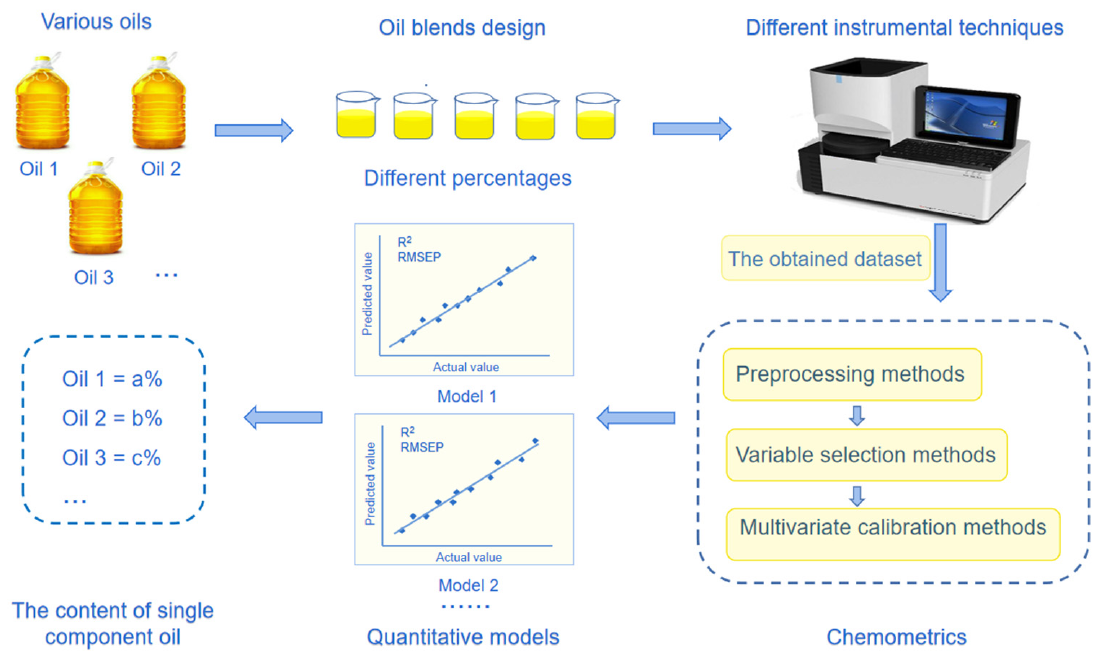
Figure 1. The general process for single component oil quantification in edible oil blends.